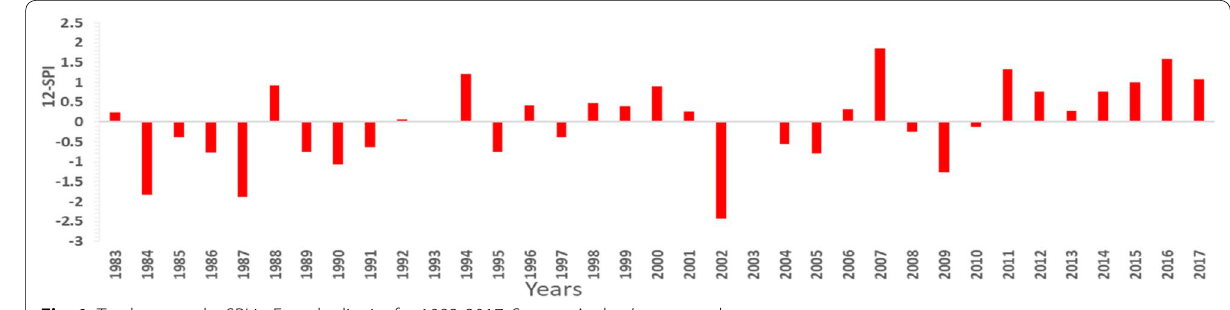
Fig. 1 Twelve-months SPI in Fentale district for 1983-2017. Source: Author’s own